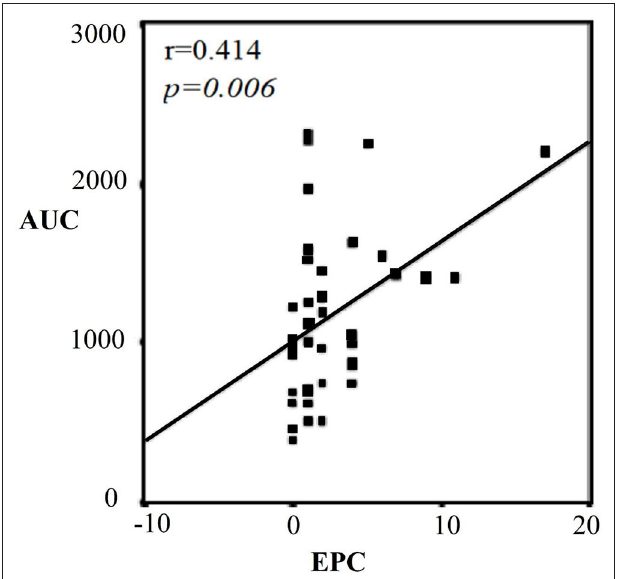
FIGURE 2 | Correlation graph between TG-AUC and CD34 + KDR + CD133 + (EPC) in men. Strong correlation between TG-AUC and early EPC numbers ( p = 0.006). AUC, area under the curve; EPC, endothelial progenitor cell.